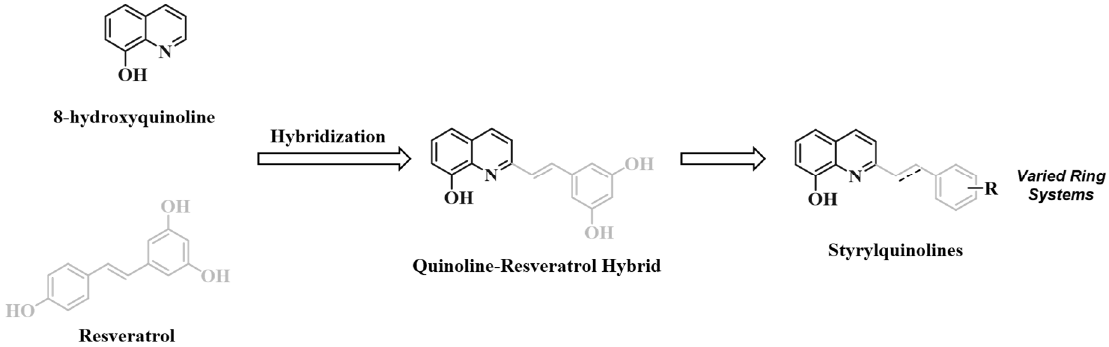
Figure 1. Design of styrylquinolines.